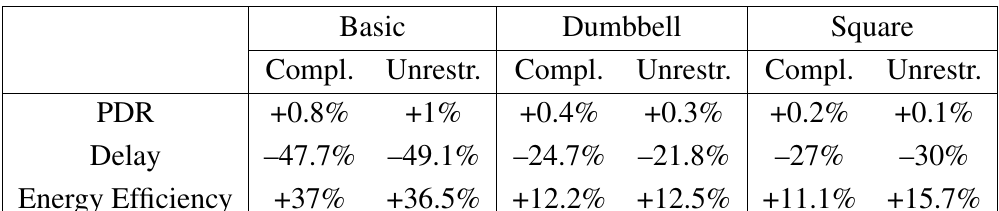
Table 6. Performance improvements achieved by the recommended stack configurations over the default ZigBee stack configuration for different topologies (increased transmission power, high traffic